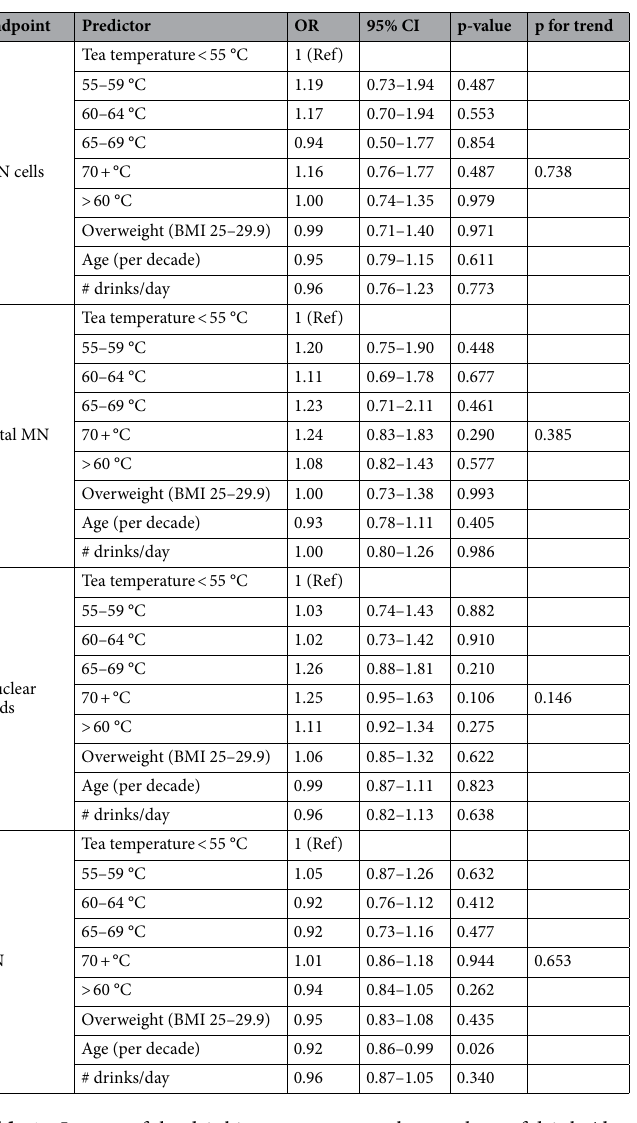
Table 1. Impact of the drinking temperature, the numbers of drinks/day and of demographic factors (age, BMI) on induction of nuclear anomalies reflecting DNA damage and disturbance of cell division in buccal cells. p-values from Poisson regression. MN Micronuclei, BN binucleated cells, OR Odds ratio, CI confidence interval. Number of participants per temperature group: < 55 °C (n = 21); 55–59 °C (n = 11); 60–64 °C (n = 15); 65–69 °C (n = 6); 70 + °C (n =